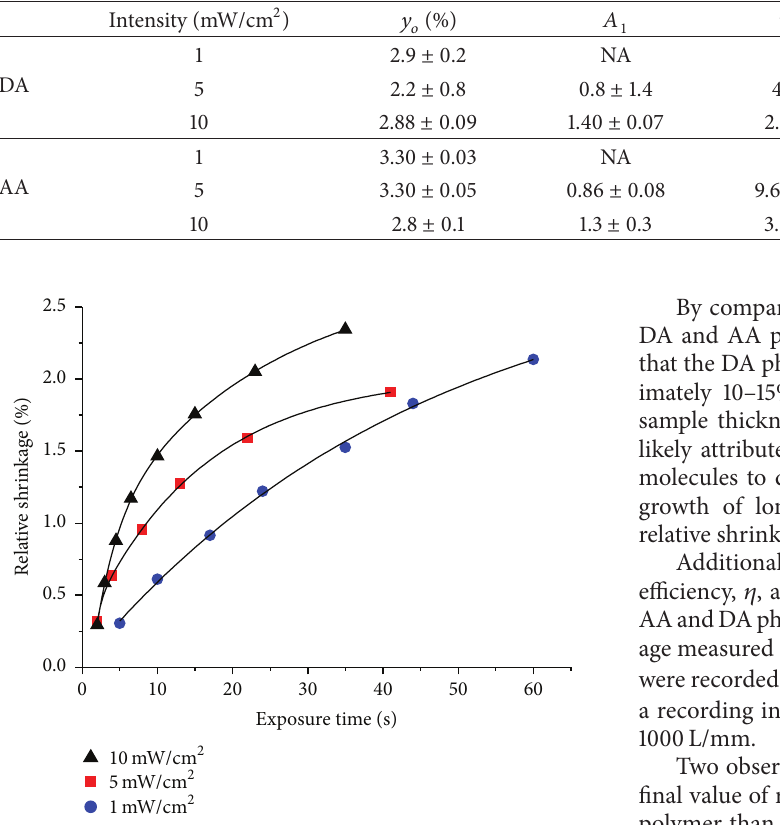
Table 2: Data from double exponential fit of relative shrinkage versus exposure time.